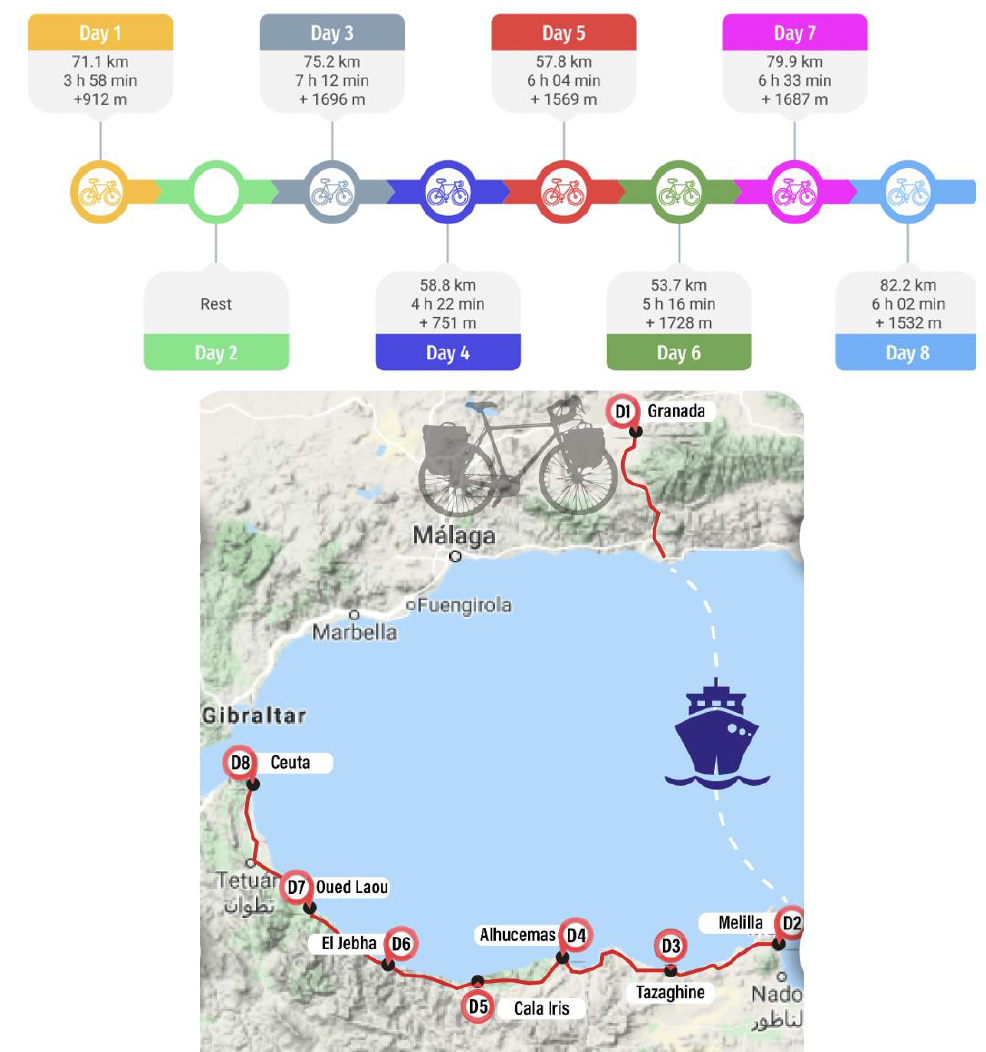
Figure 1. Description of the route.